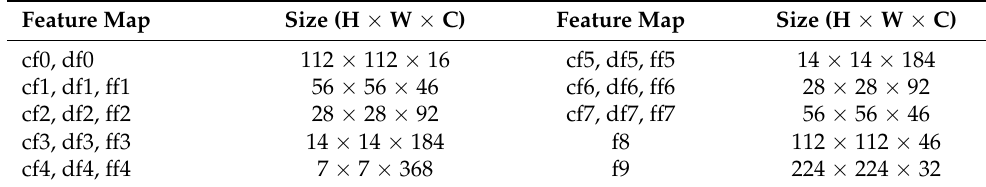
Table 1. Size of each feature map.